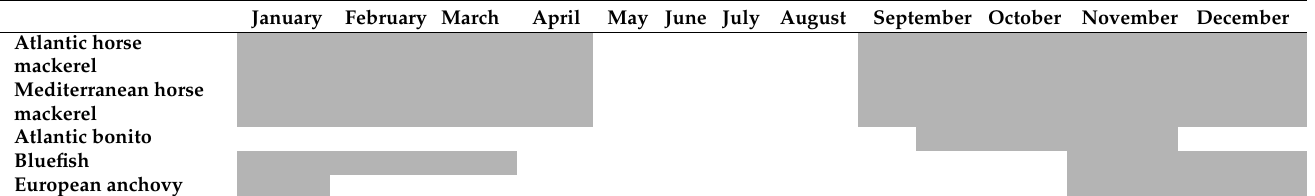
Table 1. Temporal seasonal target stock agenda of purse seiners in the Marmara Sea (structured within the knowledge of experienced purse seine fishers), with shaded grey areas indicating target